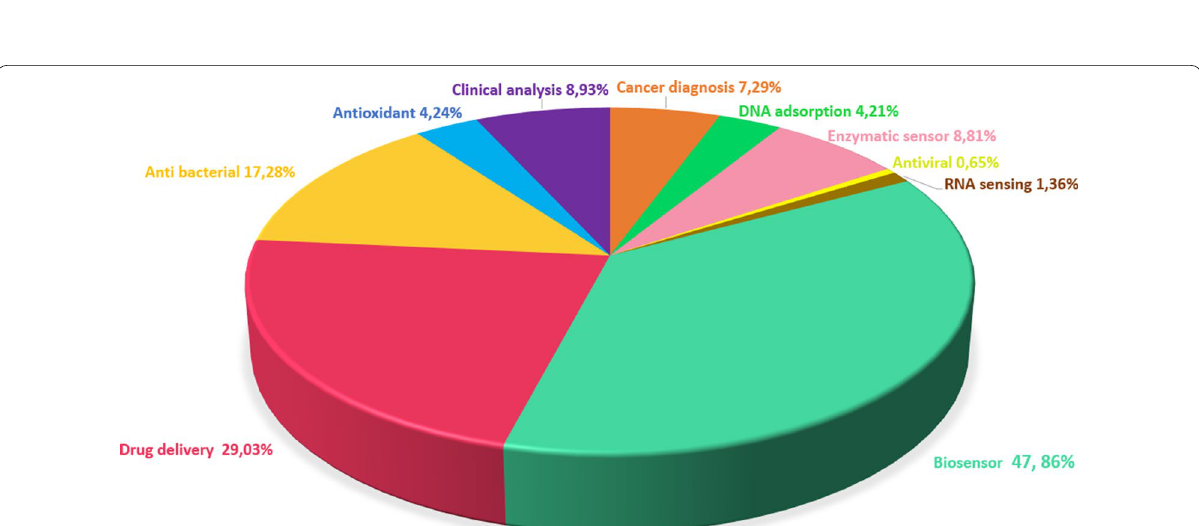
Fig. 4 Pie chart showing the distribution of graphene in biomedical